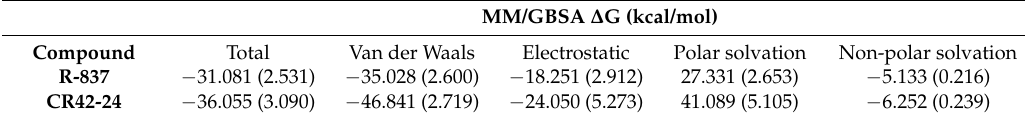
Table 1. Results from the MM/GBSA calculations over the last 5 ns of MD production trajectories of the R-837-TLR7 and CR42-24-TLR7 complexes. The total binding energies of the two compounds are in a comparable range, with the more favorable van der Waals and electrostatic contributions of the CR42-24-TLR7 complex being partially compensated by a larger, unfavorable polar desolvation term, when compared to R-837. The total values reported here do not include the entropic terms. The value of the standard deviation is reported in brackets for each